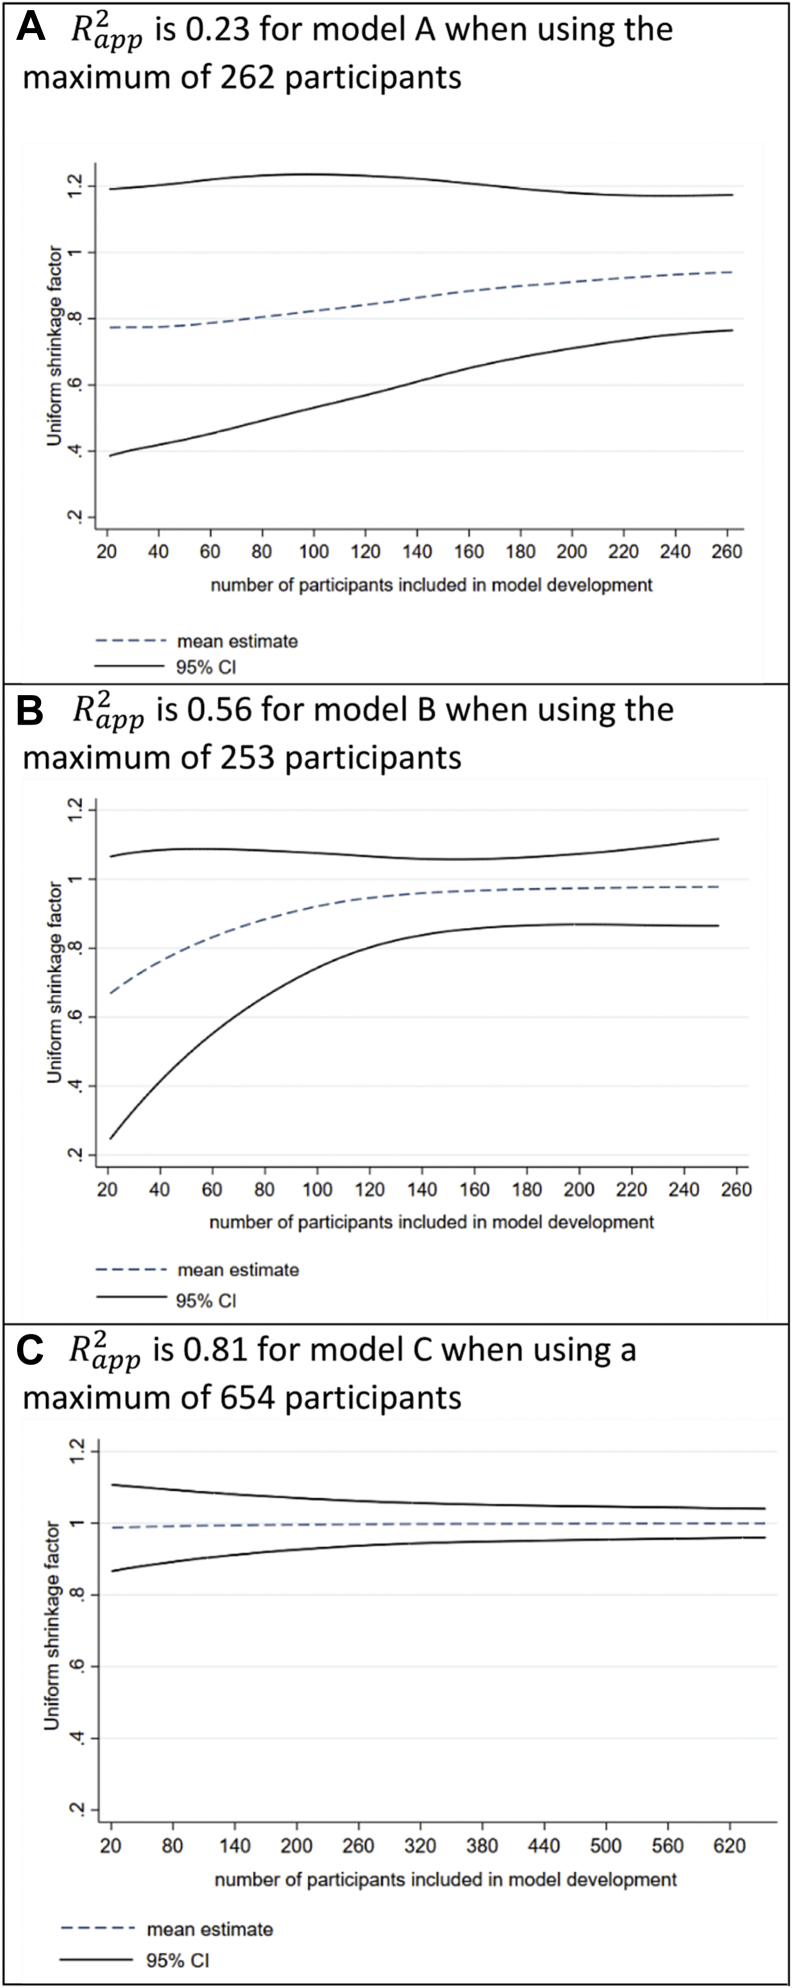
The mean estimate and 95% confidence interval of the uniform shrinkage factor (S) as derived from 1,000 bootstrap samples, across different sample sizes for developing models A, B, and C as described in Table 1. Curves are created using a lowess smoother.